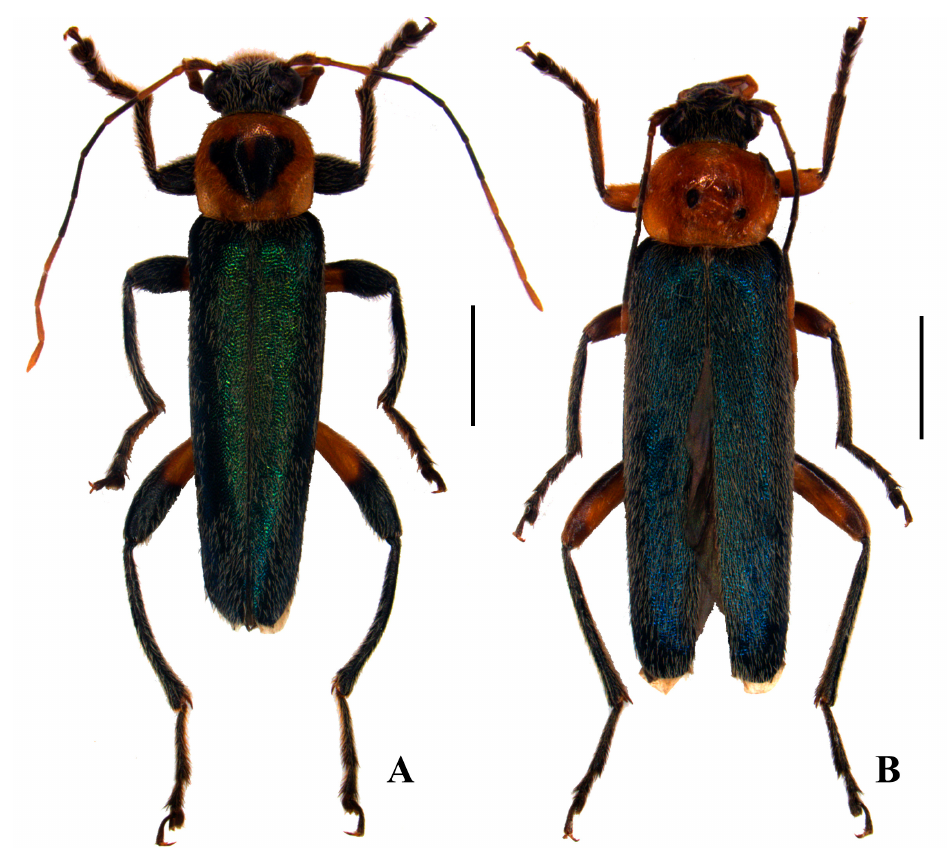
Figure 1. Habitus of Osphya sinensis sp. n., dorsal view: ( A ) male; ( B ) female. Scale bar: 2.0 mm.